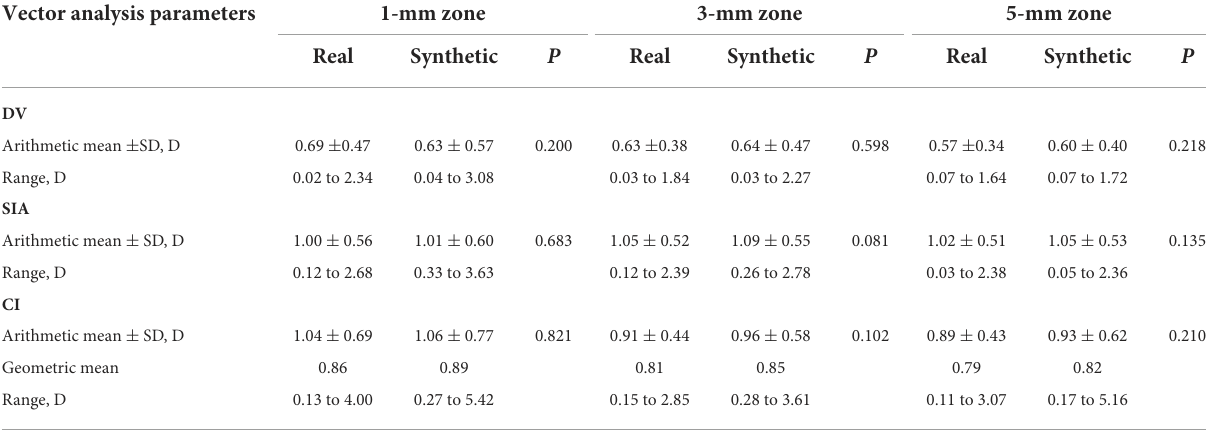
TABLE 3 Vector analysis of real and synthetic postoperative corneal axial curvature in different diameter zone. Vector analysis